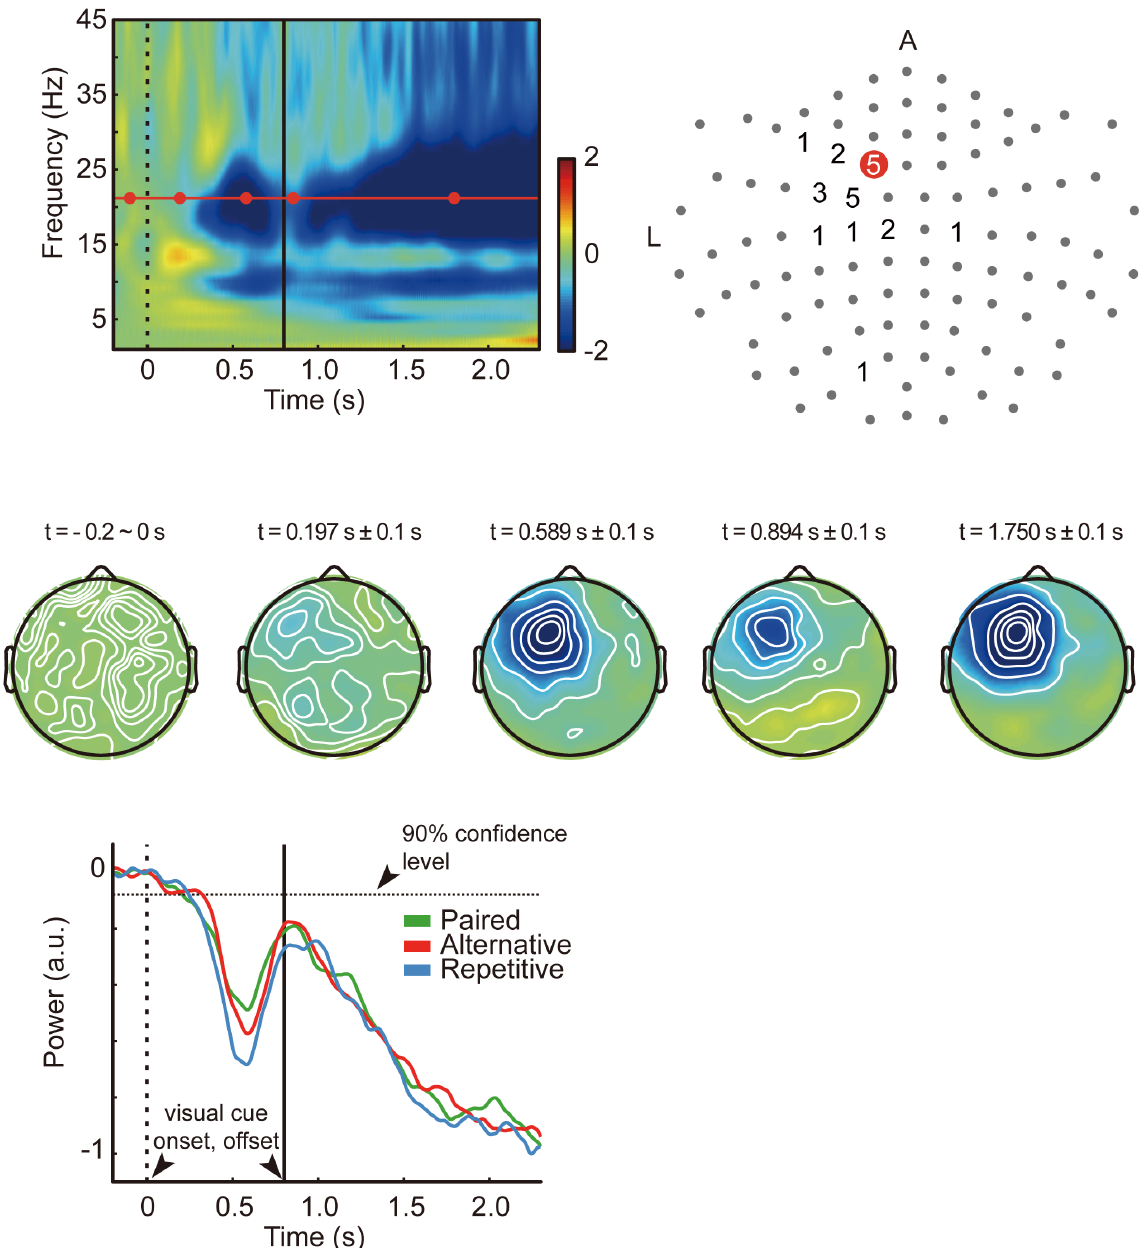
Figure 2. Beta power results from a representative subject. Top row; Time-frequency representation of data from the red sensor on the right plot for Subject 20. The horizontal red line is 21 Hz, the frequency with maximum beta power difference during visual cue display. Color bar is power in arbitrary units. The dotted and solid vertical lines are zero (visual cue onset) and visual cue offset (0.8 s), respectively (left). 102 channel full view plot and the number of subjects located at channels with the maximum beta-band power difference (right). Grey dots depict channel locations. Middle row; Topology plots of beta power during motor planning. The time points correspond to the red dots on the time-frequency plot above. Color coding is same as the time-frequency plot. Bottom row; 21 Hz power overlayed for three categories.